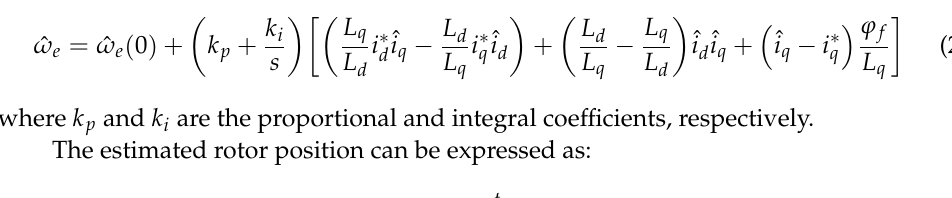
Figure 5. FESS control block diagram based on wind power frequency modulation. In the power outer loop control in Figure 5, the adjusted smooth wind power under ideal conditions is simulated according to the wind power output by a wind turbine, and the output power that needs to be compensated is obtained after the difference between the two. Calculate the specific value of (cid:1861) (cid:3044) according to (cid:1861) (cid:3044) = (cid:2877)(cid:2873)(cid:2873)(cid:2868)∙(cid:3017) (cid:2869).(cid:2873)(cid:3041) (cid:3291) ∙(cid:3101) (cid:3281) ∙(cid:3104) (cid:3549) (cid:3289) , and then input it to the current inner loop. At the same time, to ensure that the flywheel works within the safe range (3000–6000 rpm), the system is guaranteed to work within the safe range by limiting the (cid:1861) (cid:3044) input to the current inner loop. 4. Power Compensation Simulation In the simulation, the actual wind power output of a wind turbine was used for com- pensation. The specific value of the wind power was measured every minute, and the 51- min variable wind power was used as the wind power that requires compensation. In the simulation, the speed of the flywheel during the power compensation phase was 3000– 6000 rpm, the moment of inertia of the flywheel rotor was 72.95 kg·m 2 , the self-dispersion rate of the system was 2% of the rated power, and the single-rated power of the FESS was 26 kW. The stand-alone energy storage capacity is 3.6 MJ, and the discharge depth is 75%.